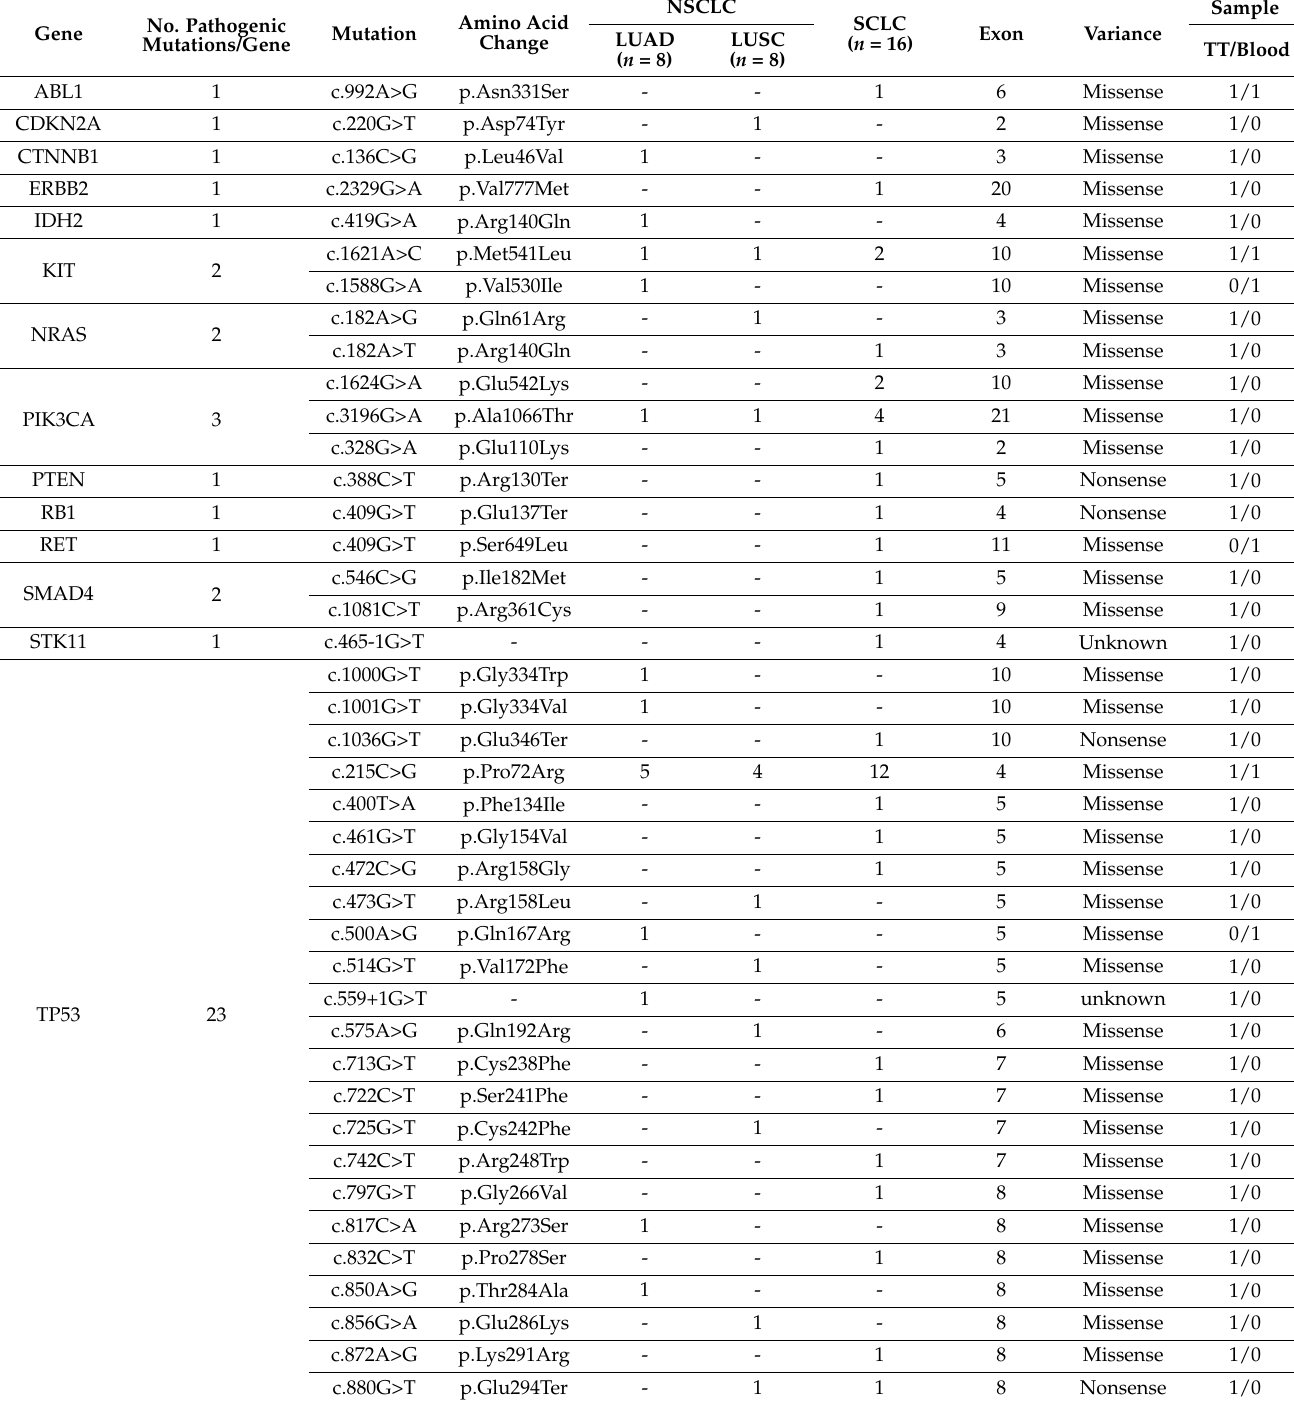
Table 3. Pathogenic mutations were identified in the experimental lung cancer